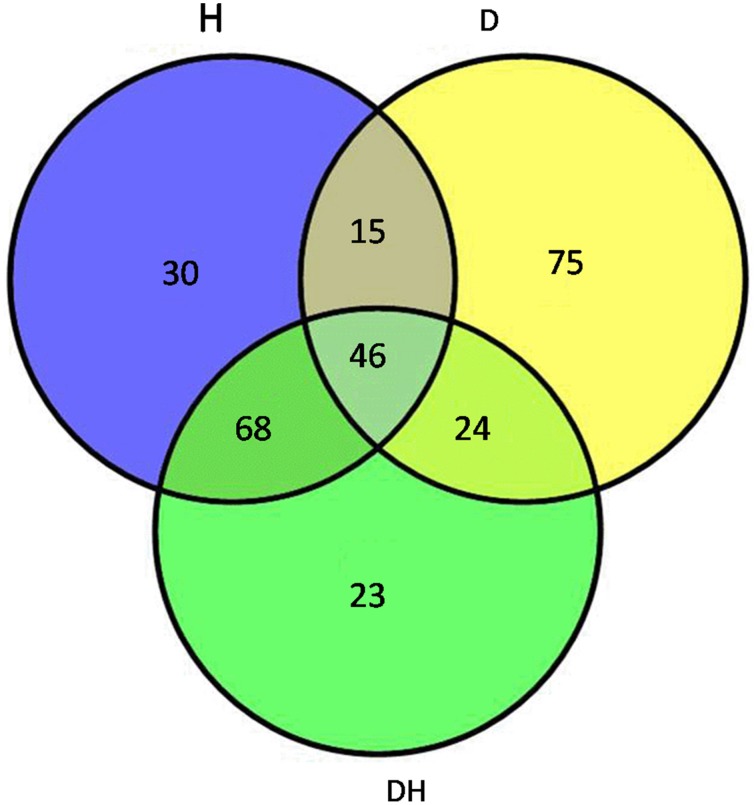
Venn diagram showing the number of proteins with significant changes in phosphorylation levels in maize leaves exposed to drought (D), heat (H) and combined drought and heat stress (DH). The diagram shows the overlap between the results from D, H, and DH.